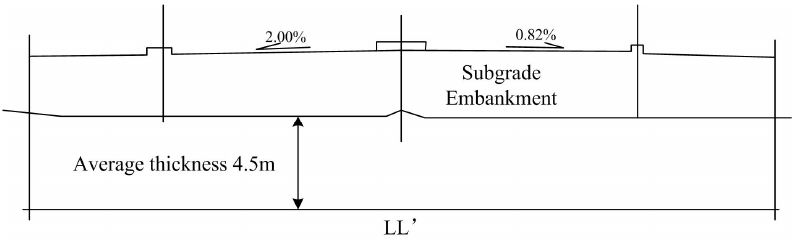
Figure 4. Transversal profile of test highway at LL’ in Figure 2b.